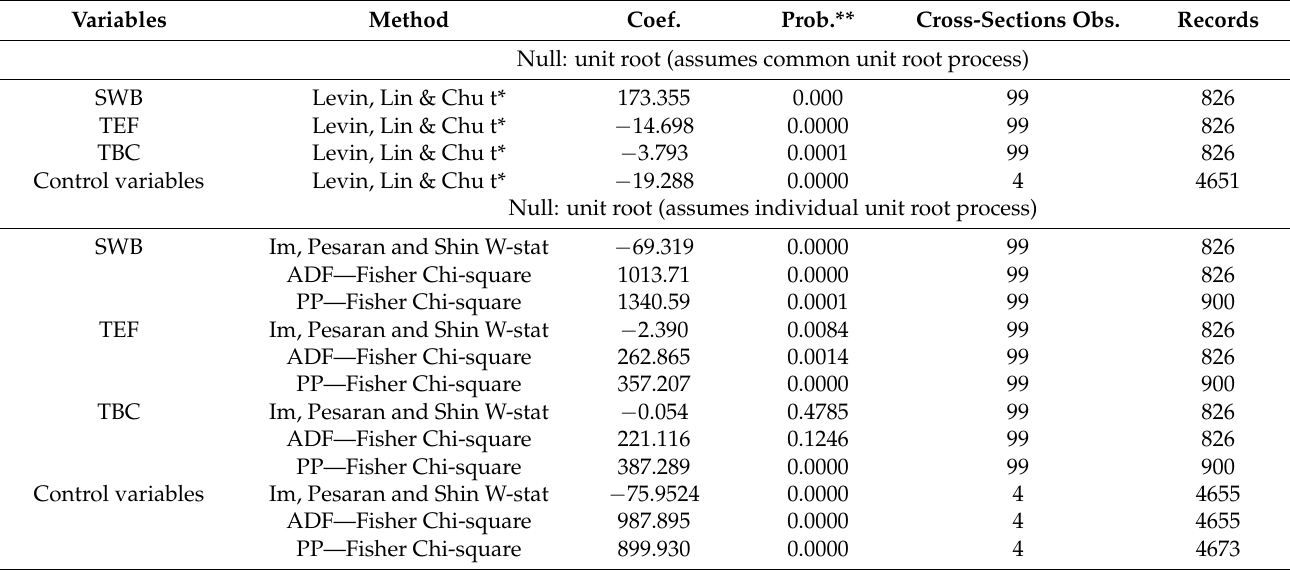
Table 1. The result of panel unit root of